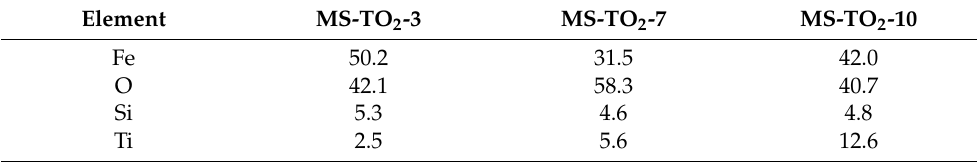
Table 1. Element weight percent (wt.%) by EDS for MS-TiO 2 prepared under different pHs.